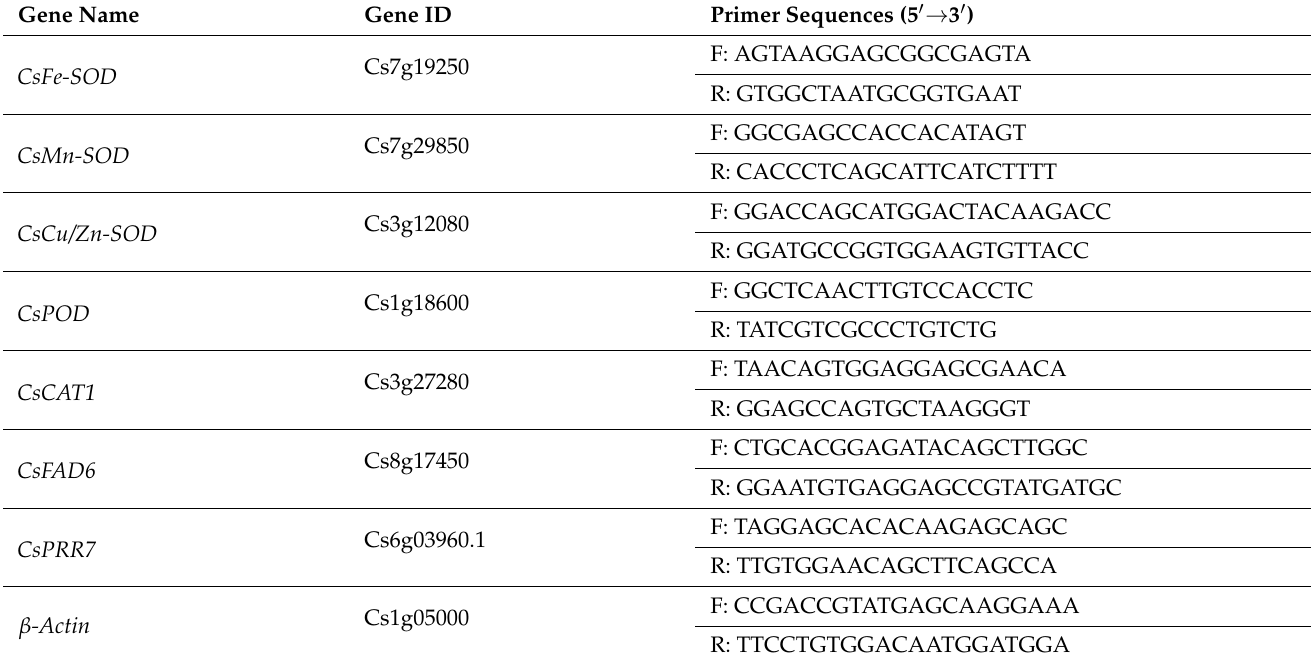
Table 1. Specific primer sequences of genes used for qRT-PCR.